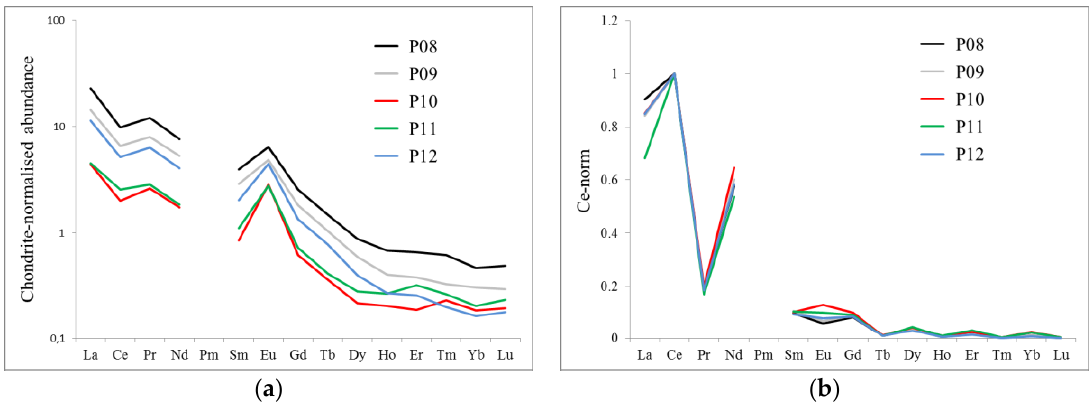
Figure 5. REE distributions in wines from different vintages: ( a ) chondrite-normalized values; ( b ) Ce-normalized values.